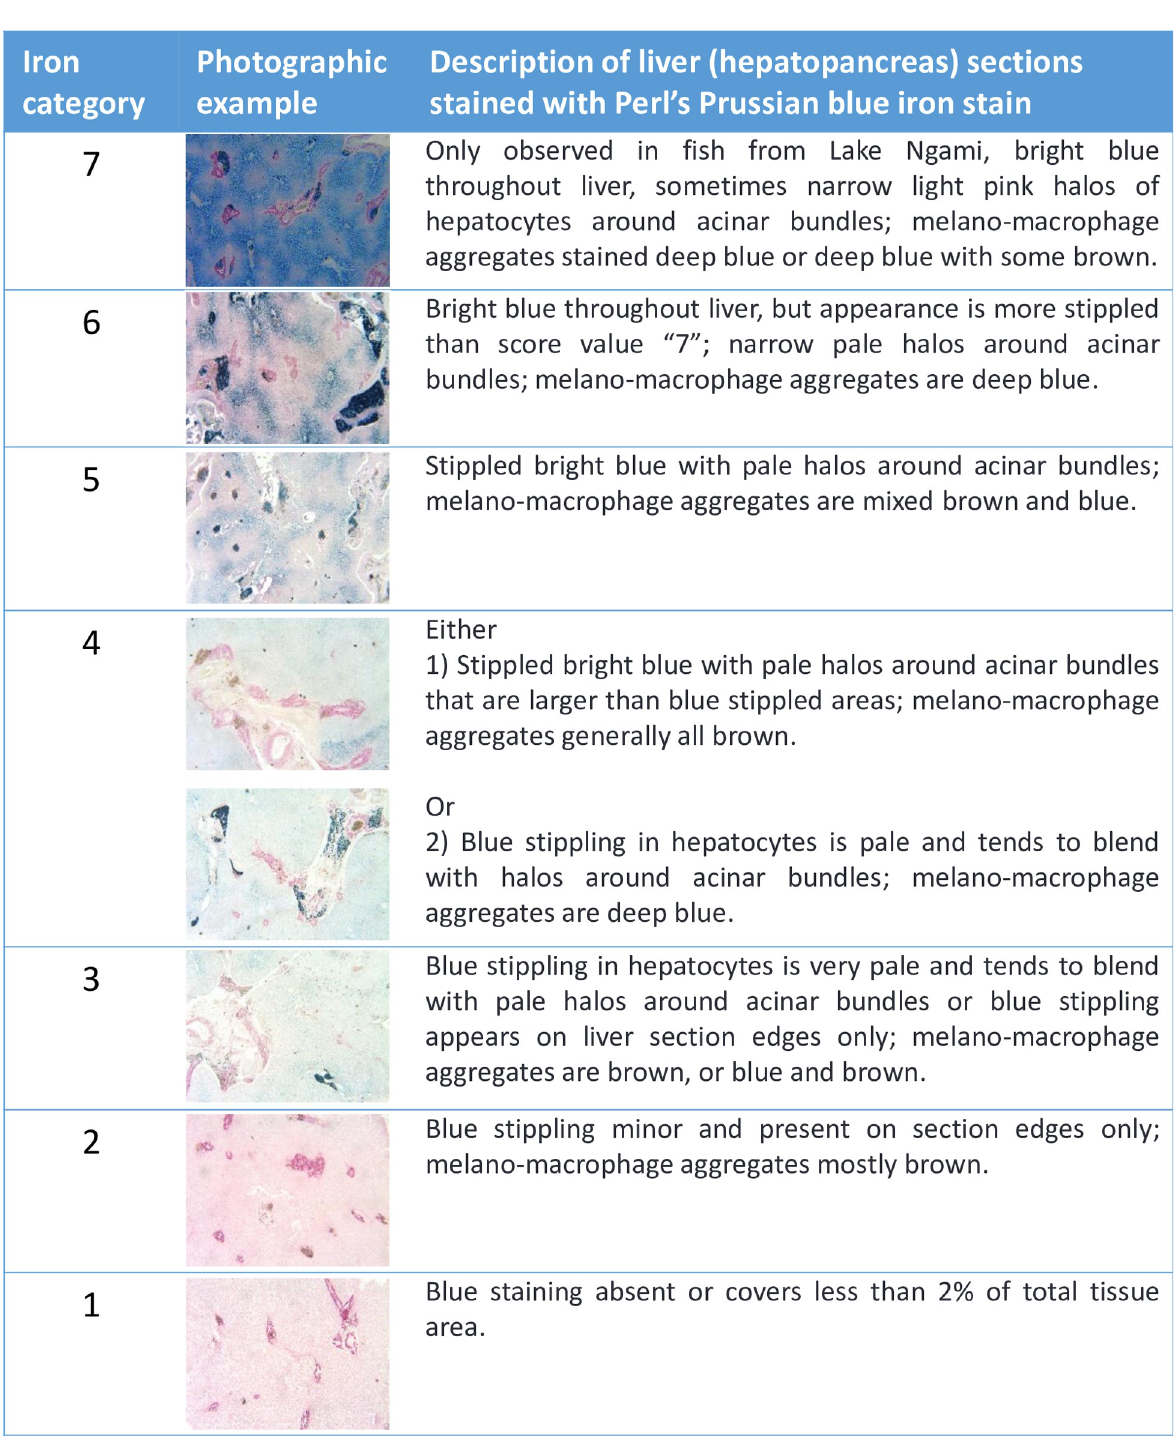
Fig 2. Iron category definitions for liver (hepatopancreas) sections stained with Perl’s Prussian blue iron stain. Categories 1–7 reflect the degree of iron staining in liver sections, with 7 representing the most iron. Category 7 was only observed in Lake Ngami fish. Higher resolution images are available in S1